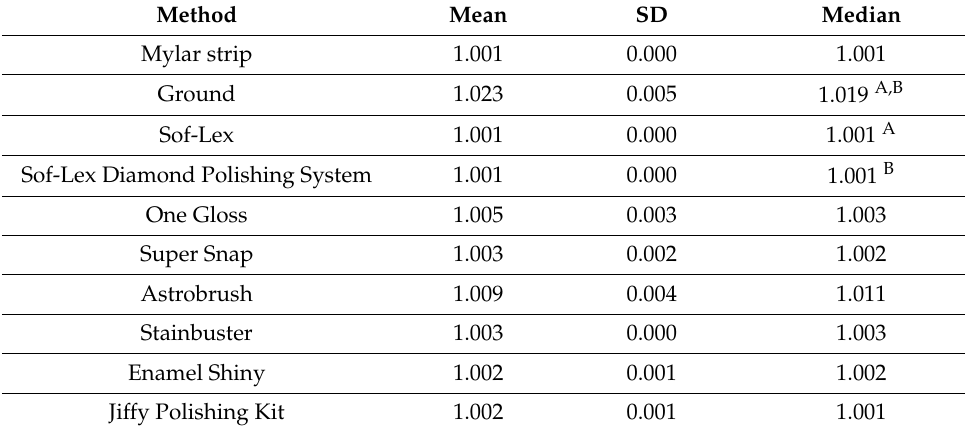
Table 6. Descriptive statistics, Rlr for Filtek Z250.